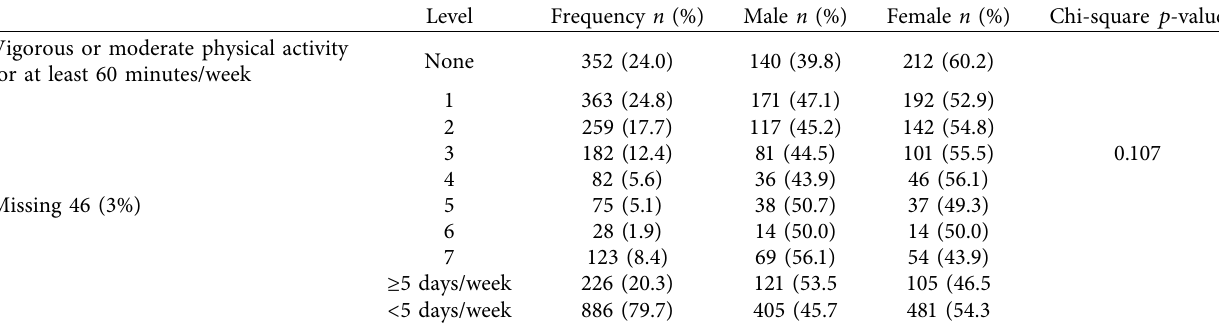
Table 5: The distribution of moderate-to-vigorous physical activity during COVID-19 restriction among 1500 adolescents in the KSA.